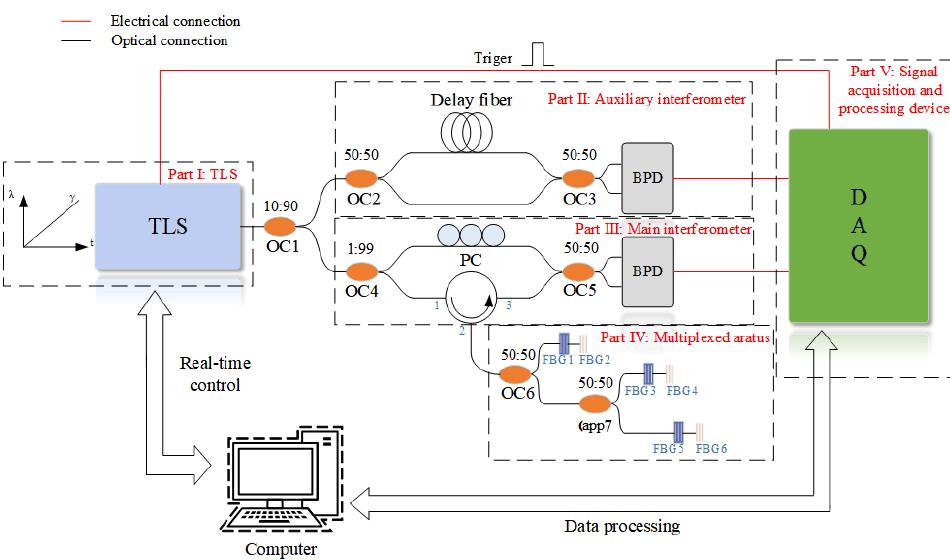
Figure 2. Multi-point strain measurement system with temperature compensation. TLS: tunable laser source; OC: optical coupler; BPD: balanced photodetector; PC: polarization controller; DAQ: data acquisition card.